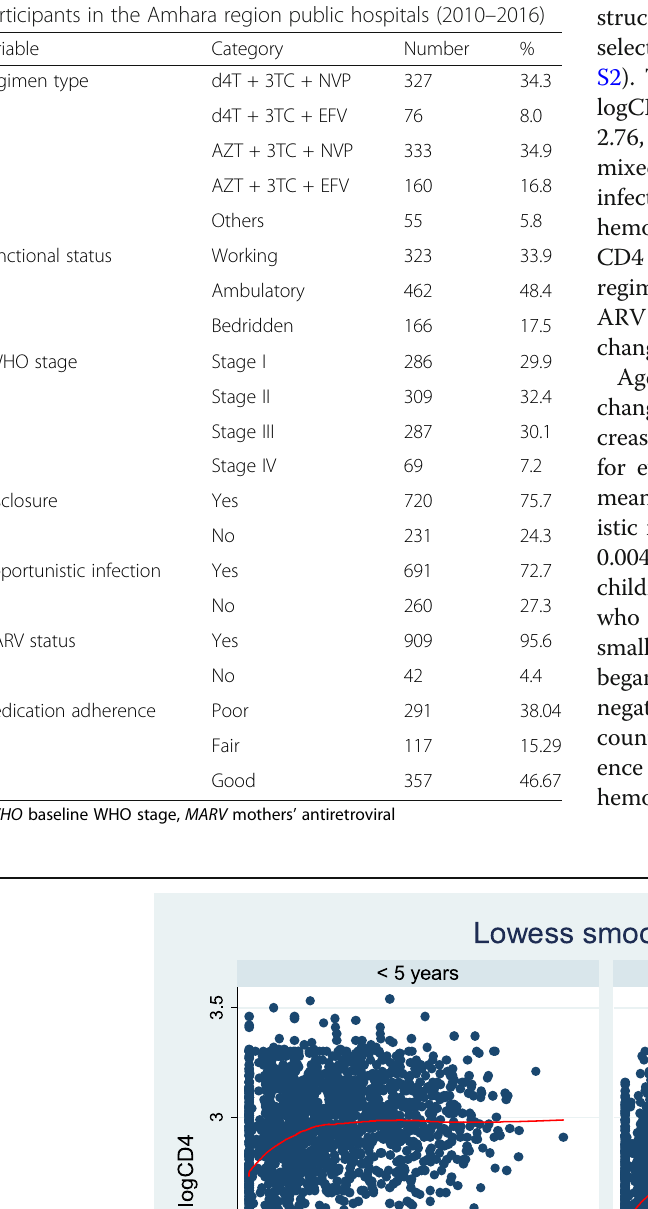
Table 2 Clinical and medication characteristics of study participants in the Amhara region public hospitals (2010 – 2016)